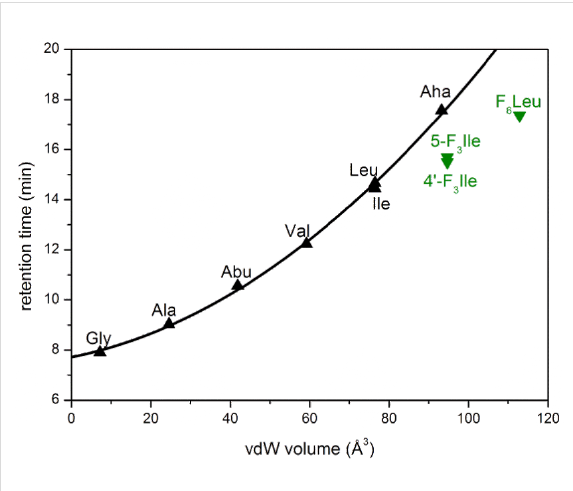
Figure 1: Retention times of Fmoc amino acids plotted against the van der Waals volume of their side chains. Non- fl uorinated amino acids are depicted as black triangles; their correlation is shown as a black line. Fluorinated amino acids are represented by green triangles.